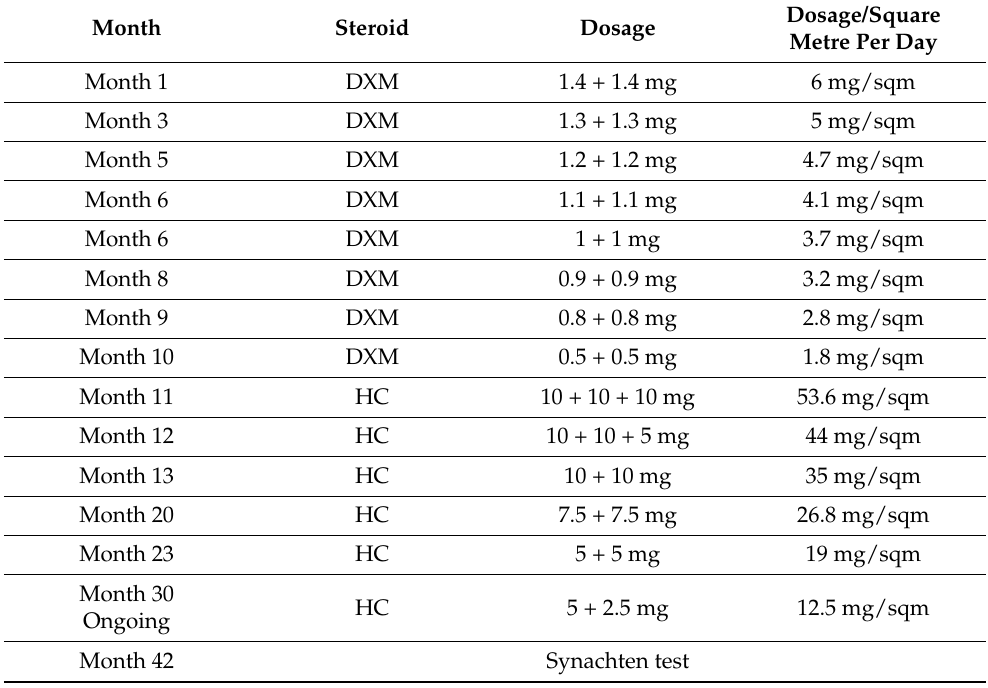
Table 1. Progressive tapering of steroid therapy: DXM—dexamethasone; HC—hydrocortisone.